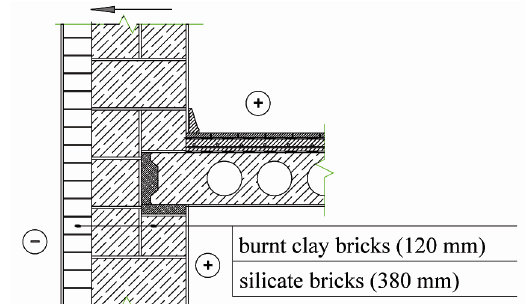
Fig. 1. Vertical section of the wall before renovation. The wall consist of two masonry layers, the first is 380 mm in width and the second is 120 mm in width